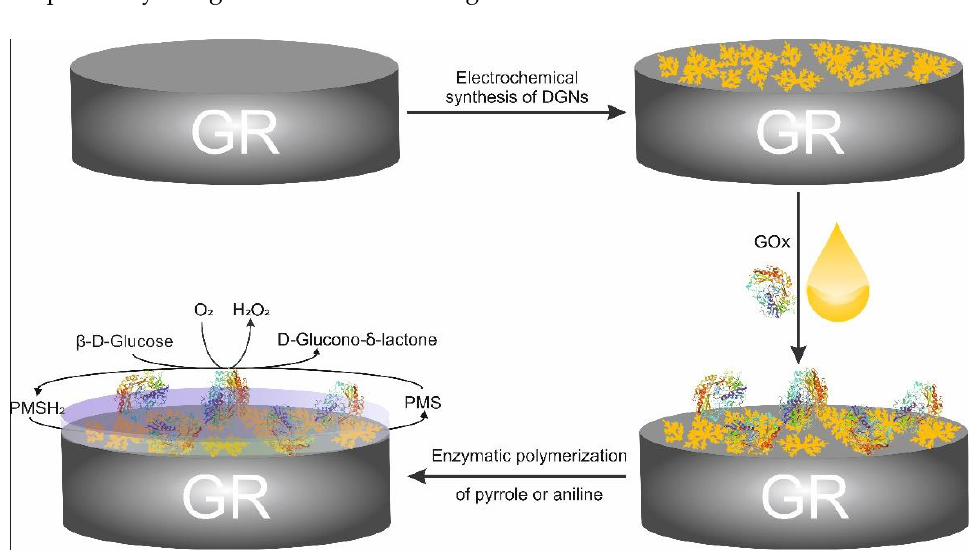
Figure 1. Schematic representation of GR electrode modification with dendritic gold nanostructures with the following immobilization of GOx and the enzymatic formation of the polymer (PANI or Ppy) layer for the electrochemical glucose determination. Ppy) layer for the electrochemical glucose